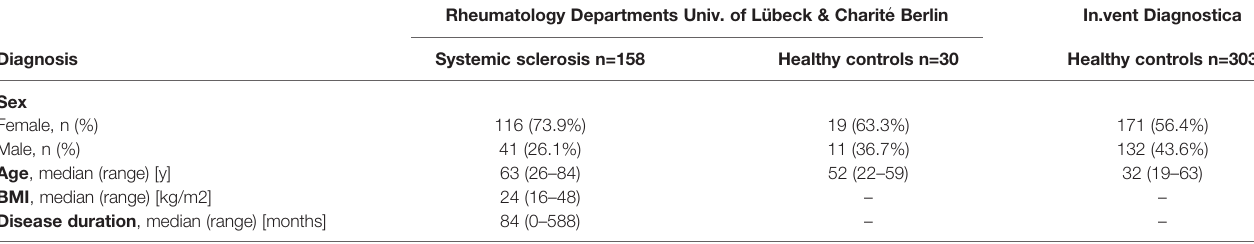
TABLE 1 | Baseline characteristics of the study